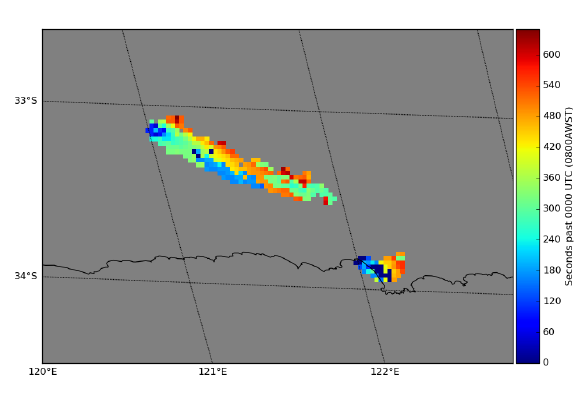
Figure 4: Map of first positive anomaly return for calendar day 2015-11-17 for pixels which recorded a brightness temperature greater than 335 K at any